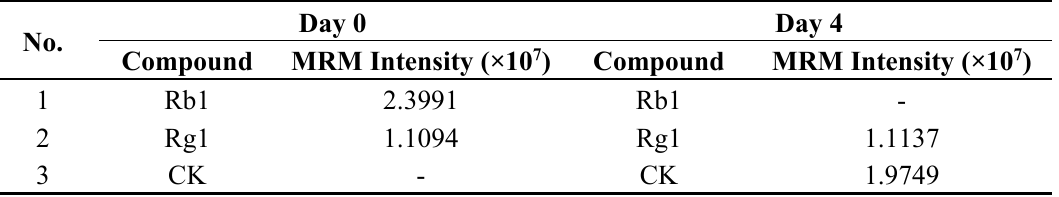
Table 2. MRM intensity of Rb1, Rg1, CK before and after the biotransformation. No.